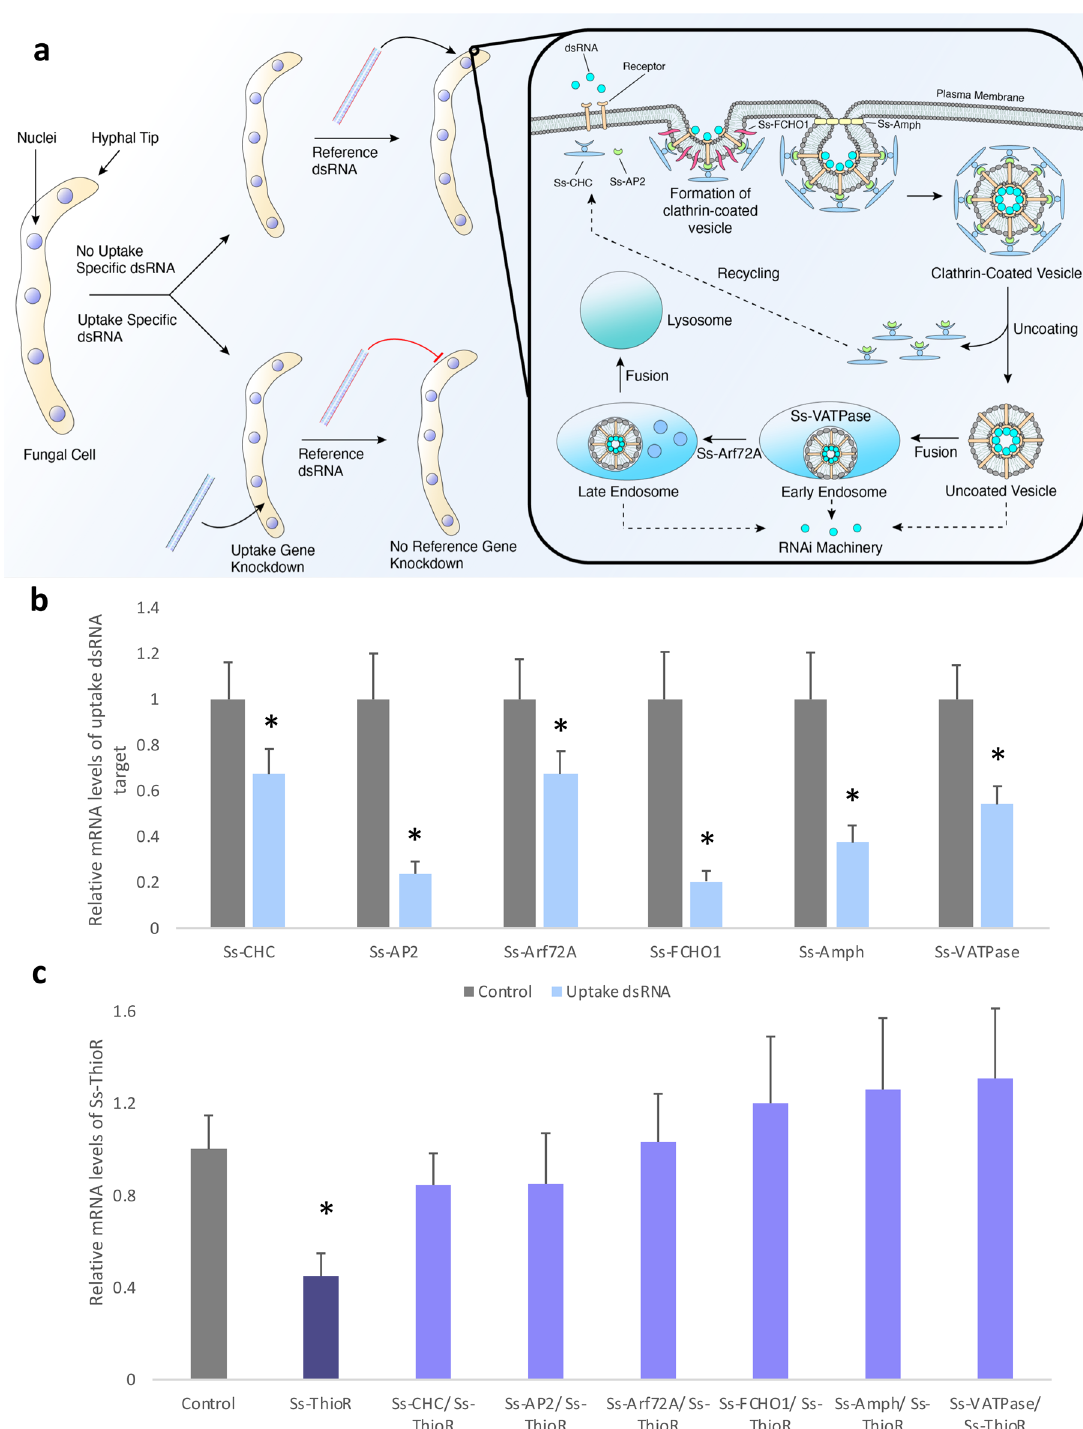
Figure 3. An RNAi of RNAi experiment to identify proteins involved in dsRNA uptake. ( a ) The knockdown of genes involved in uptake will inhibit further uptake of reference dsRNA and thus prevent its knockdown. Whereas in cultures untreated with uptake dsRNA, reference dsRNA will be taken up via our proposed uptake mechanism. The binding of exogenous dsRNA to its receptor induces the localization of clathrin and its adaptor to the membrane. FCHO contributes to the invagination of the vesicle and amphiphysin to its release from the membrane. Arf72A aids in the transition from early to late endosome, and vesicle acidification via VH + ATPase induces cytoplasmic dsRNA release. ( b ) In vitro cultures were first treated with 500 ng/mL of dsRNA targeting putative uptake genes (Ss-CHC, Ss-AP2, Ss-Arf72A, Ss-FCHO1, Ss-Amph and Ss-VATPase) and transcript levels of each gene was assessed by quantitative real-time PCR 4 days later. Asterisk denotes significant knockdown of the targeted gene (one-tailed t-test, with a Bonferroni correction p < 0.05 from three independent biological replicates). ( c ) At day 4, a second dsRNA, targeting Ss-ThioR, was applied, and Ss-ThioR transcript levels were measured after an additional two days. Asterisk denotes significant difference relative to the negative control (one-tailed t-test with Bonferroni correction, p < 0.05 from three independent biological replicates). Note that only the hyphae treated with Ss-ThioR dsRNA alone resulted in significant difference from the